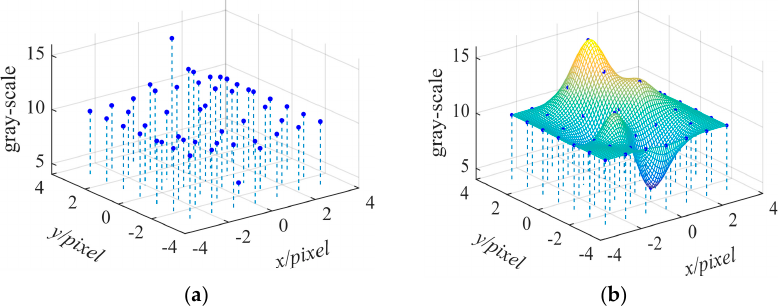
Figure 2. Bicubic spline interpolation diagram: ( a ) the discrete grayscale points of integral pixel; ( b ) the bicubic spline interpolated graph. Notes: The negative pixel in this figure does not mean that it is absolutely negative, but only represents relative